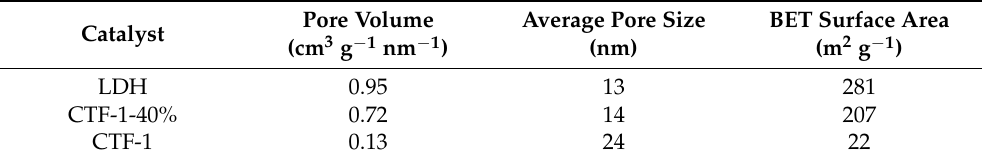
Table 1. BET surface area and pore volume of LDH, CTF-1, and the LDH/CTF-1-40% samples.